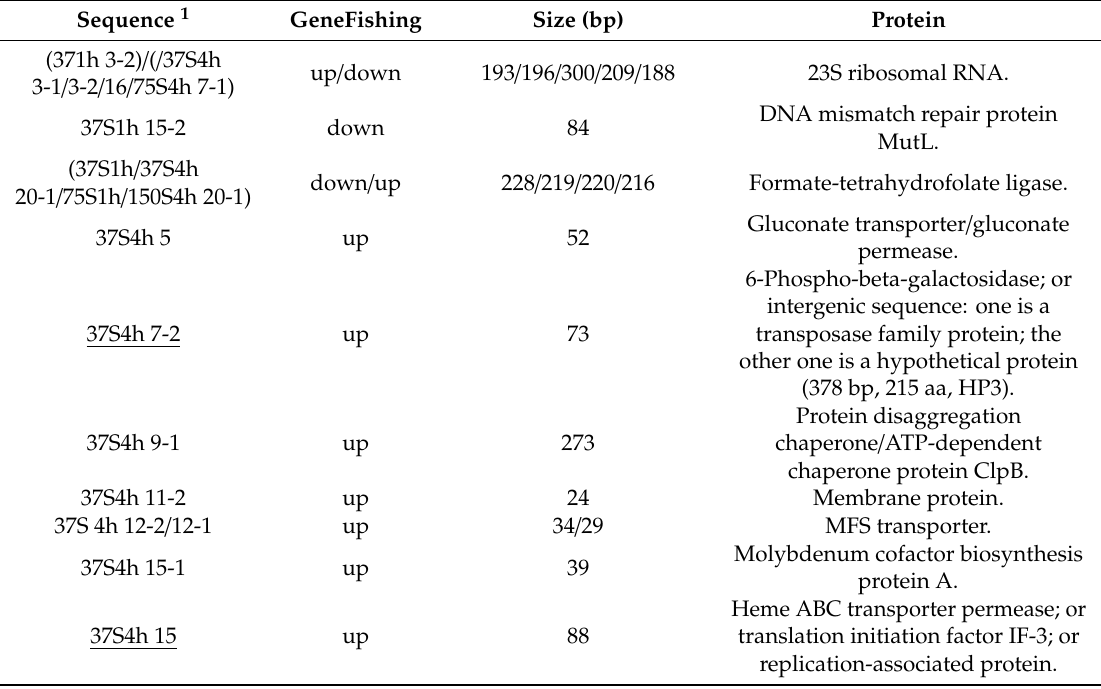
Table 1. The di ff erentially expressed gene fragments determined by the GeneFishing DEGs